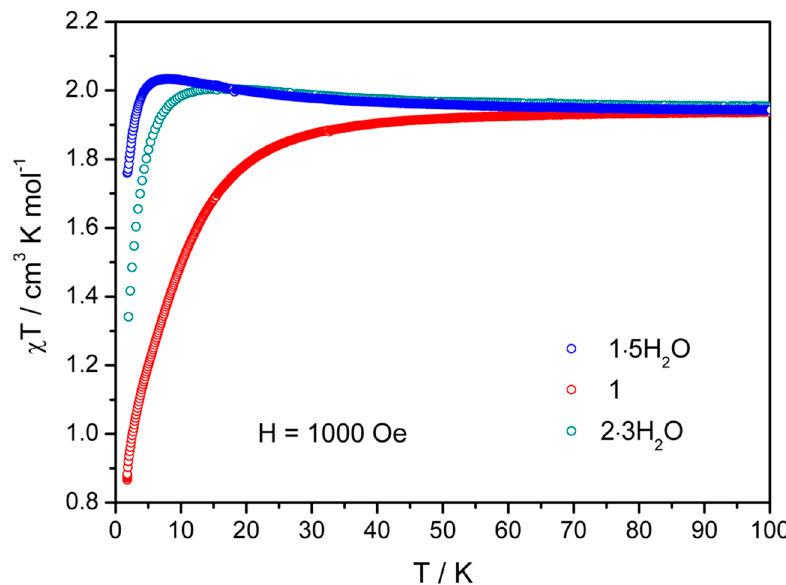
Figure 5. Temperature dependence of the DC magnetic susceptibility at 1000 Oe for 1·5H 2 O , 1 and 2·3H 2 O .